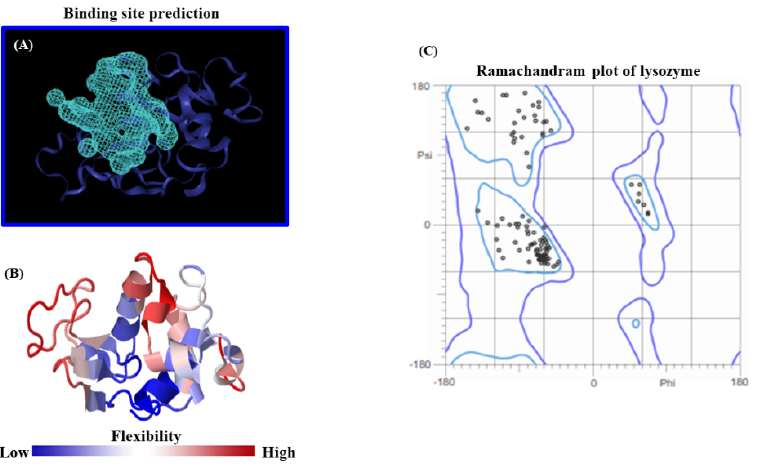
Figure 5. ( A ) Top view of the fpocket prediction for the best-ranked lysozyme binding site crystallographically validated by Deepsite software considering its position in the lysozyme. Herein, the obtained maximum cavity volume was equal to 431.26 Å 3 (i.e., represented here by the light blue mesh-volumetric Van der Waal map) which involves the binding residues interacting with the BTS-ligand. At the bottom, ( B ) represents the lysozyme flexibility profile as a 3D-colored structure, according to the size of fluctuations driven by the whole structure from regions with low-flexibility (blue) to high-flexibility (red). In the right, ( C ) corresponds to the obtained Ramachandran plot for all the possible combinations of Psi vs. Phi dihedral torsion angles of the modeled lysozyme protein. Here, the area inside the Ramachandran contour line (purple color) shows the spatial distribution of conformationally favored residues (black dots), while the outlier or conformationally unfavored non-binding residues are fully absent for this instance.